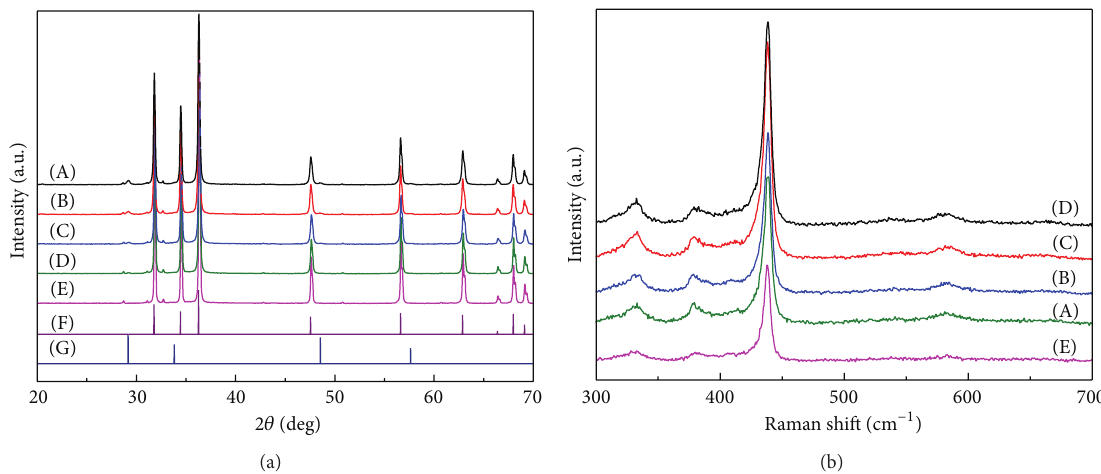
Figure 1: XRD patterns (a) and Raman spectra (b) of ZnO (E), 0.25%-Y 2 O 3 -ZnO (D), 0.50%-Y 2 O 3 -ZnO (C), 0.75%-Y 2 O 3 -ZnO (B), and 1.00%-Y 2 O 3 -ZnO (A), JCPDS Card number 36-1451 (F) and JCPDS Card number 65-3178 (G).